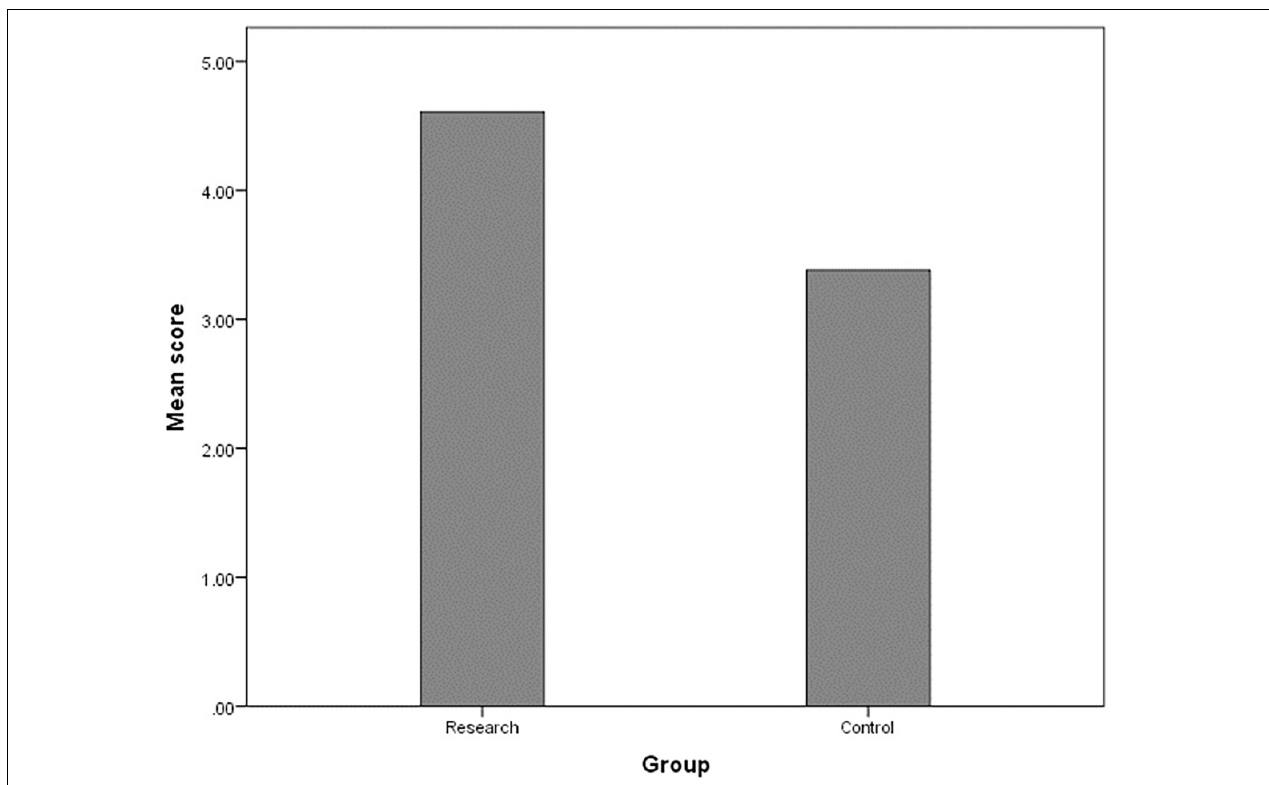
FIGURE 2 | Between-group differences on three levels of knowledge (total mean